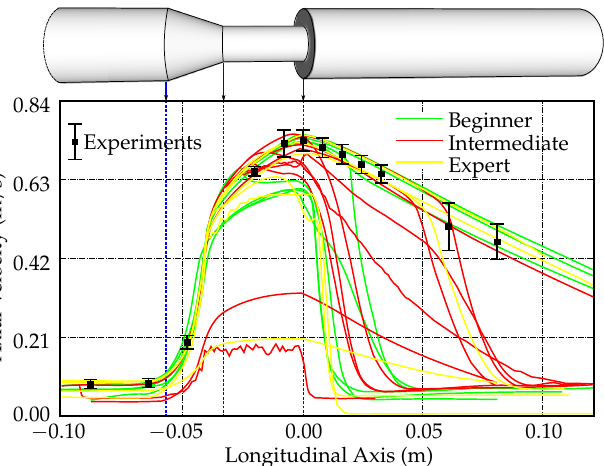
Figure 2. In the Food and Drug Administration (FDA) study [72], the participants were requested to provide simulation data along the model centerline, among others. The results of the study for Reynolds number of 500 are shown here. The graph was re-created based on the data from